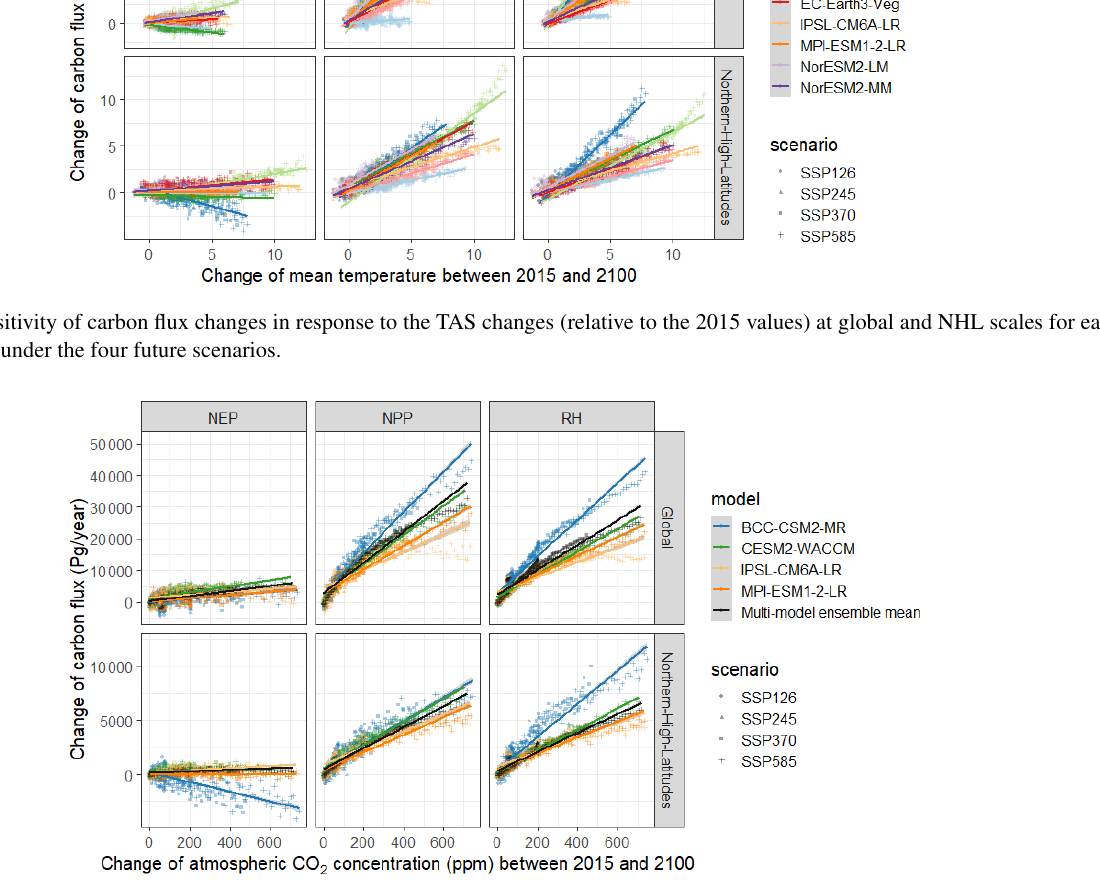
Figure 3. Sensitivity of carbon flux changes in response to the CO 2 concentration changes (relative to the 2015 values) at global and NHL scales for each CMIP6 model under the four future scenarios. Only available data from four CMIP6 models were used for producing this